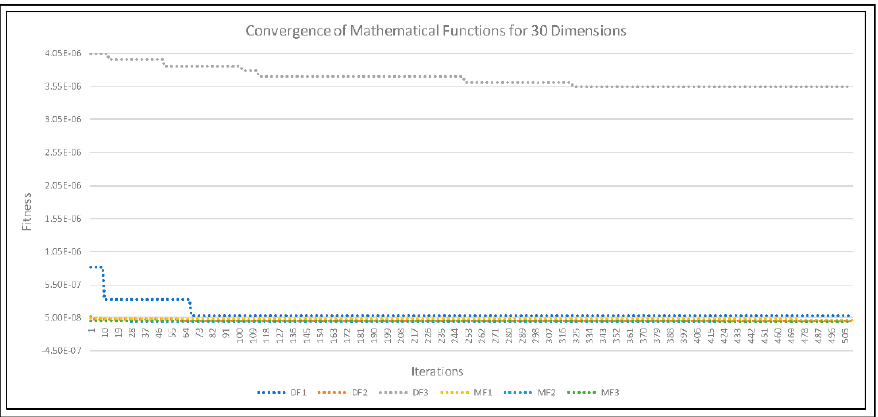
Figure 9. Convergence of the DMOA and MTOA algorithms for 30 dimensions, for the functions F1, F2, and F3.